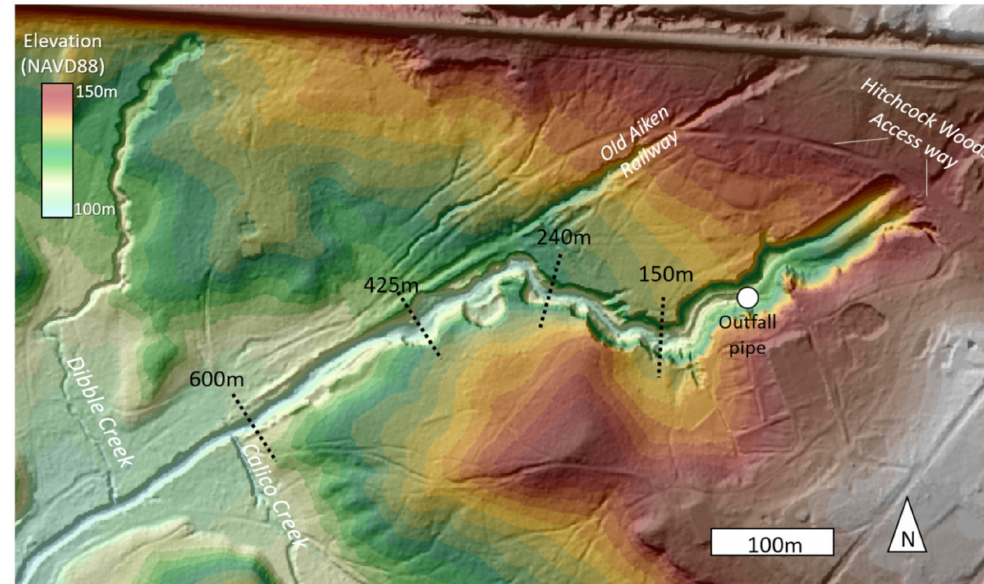
Figure 5. 2012 lidar DEM of the Sand River study reach. Warm to cool colors represent high to low elevations, respectively. The black dashed line marks the transect locations used to generate cross section channel